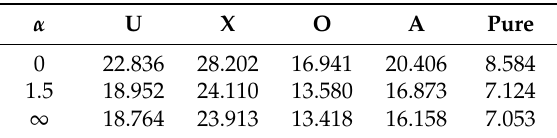
Table 2. Effect of graphene nanoplatelets (GPL) distribution patterns on buckling load ( S / h = 80, W GPL = 0.5%, λ = 12).